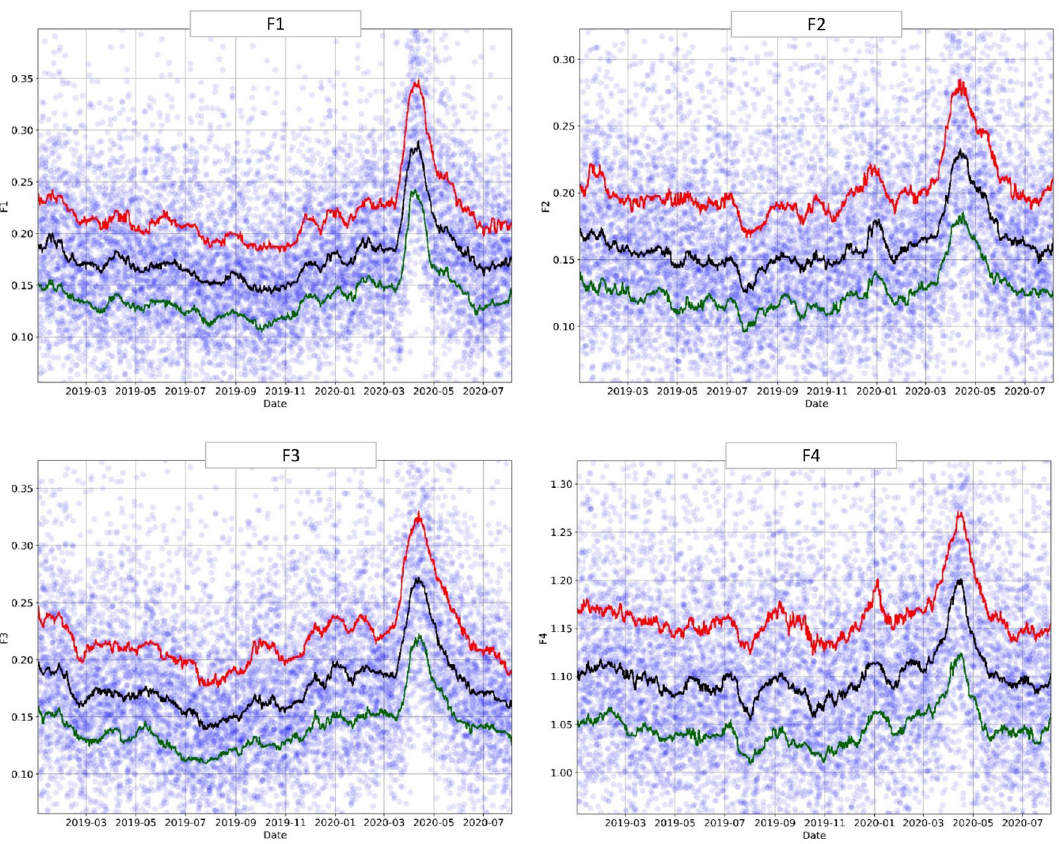
Figure 6. Engineered feature (F1-F4): trends over time (January 2019–August 2020). The circles represent the original data averaged over 6-h intervals, and the lines—moving percentile curves for 25%, 50%, and